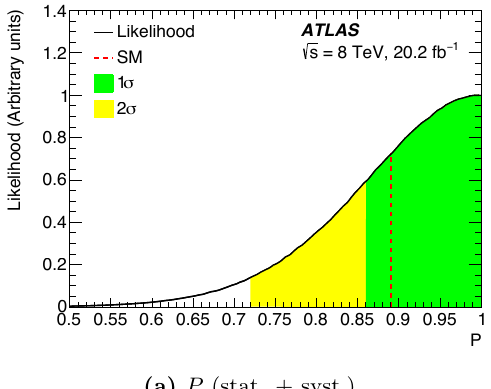
Figure 10. The likelihood pro(cid:12)le for the top-quark polarisation P is shown. The black line indicates the evaluated likelihood in each bin of the pro(cid:12)led variable. The red dashed line represents the SM expectation. The 68% and 95% CL regions are shown in green and yellow,